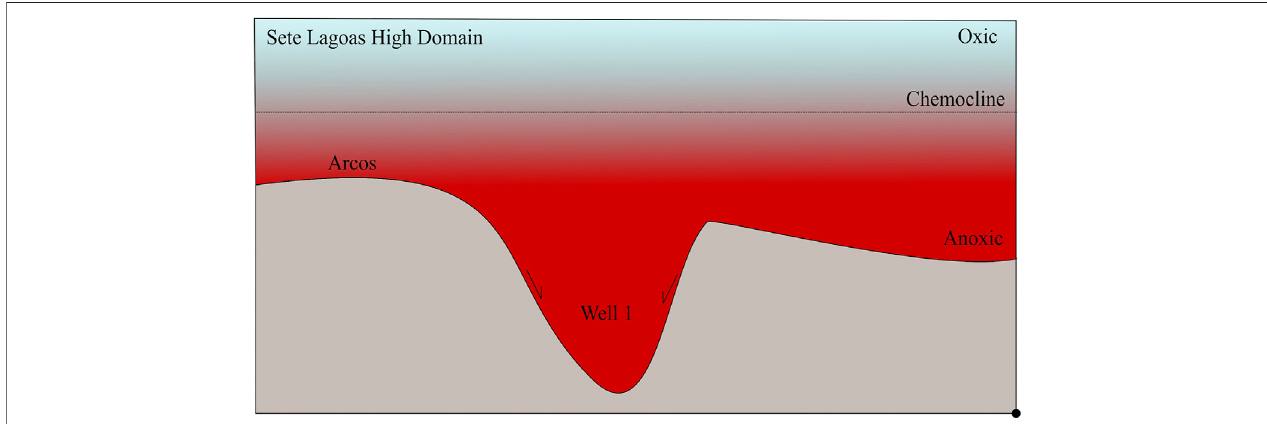
FIGURE 11 | Schematic representation of the Sete Lagoas High Domain. Well 1 is located inside a forebulge graben and Arcos in a shallower part of the Sete Lagoas Domain. Hence, if we consider that the chemocline was at the same level, Well 1 had a deeper anoxic water column than Arcos.